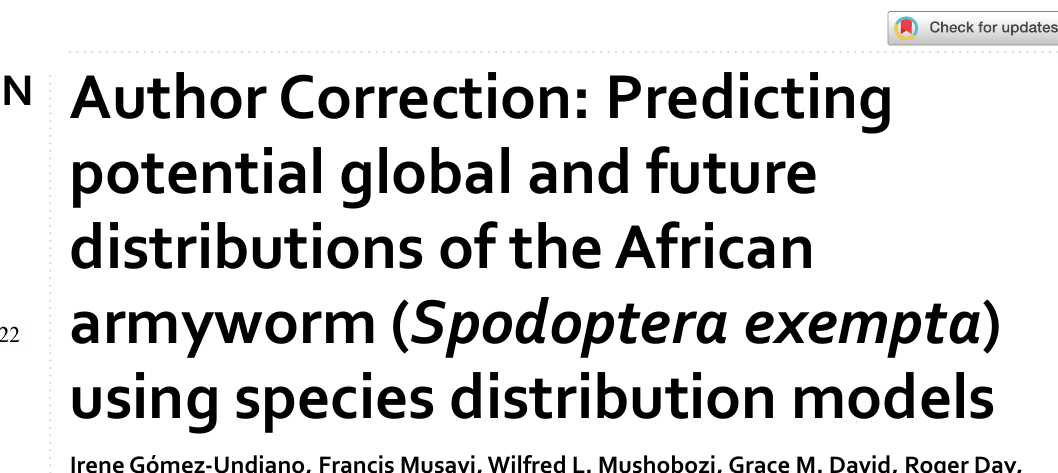
“ Figure 3 . S. exempta future environmental suitability maps for Kenya and Tanzania for 3 different CO 2 emis- sion scenarios and two different time periods. ( A ) 2021-2040 SSP1-2.6, ( B ) 2021-2040 SSP3-7.0, ( C ) 2021–2040